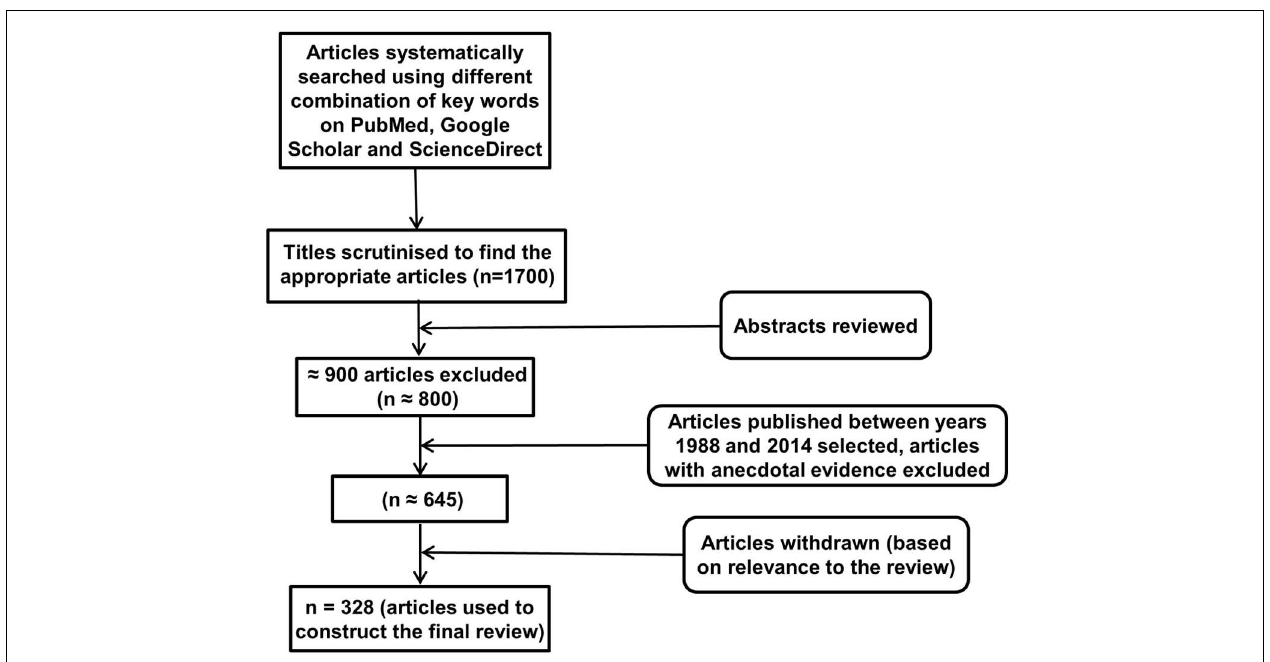
FIGURE 1 | Study inclusion flowchart. It depicts the methodology for search and collection of relevant articles for this review, following PRISMA guidelines (Liberati etal., 2009; Moher etal.,